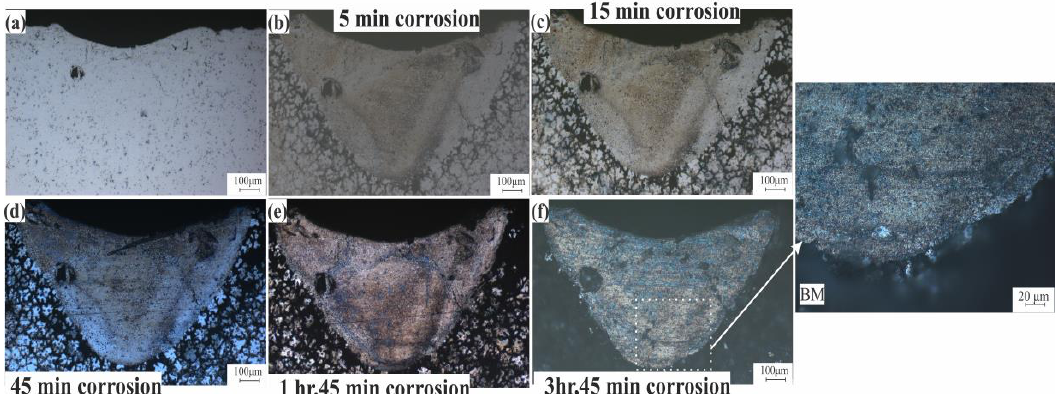
Figure 13. Intergranular corrosion of AA7075-ScZr after ( a ) laser, ( b ) 5 min, ( c ) 15 min, ( d ) 45 min, ( e ) 1 h and 45 min, and ( f ) 3 h and 45 min.